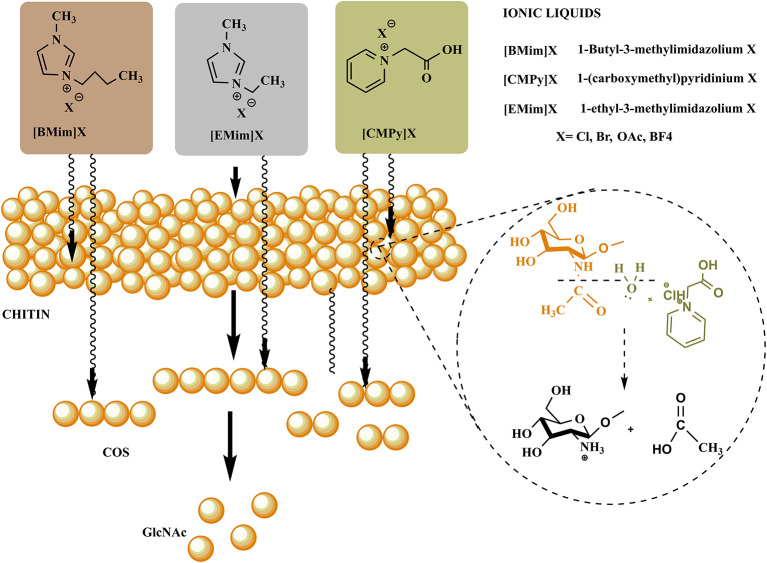
Conventional and emerging green chemicals based production steps of COS and GlcNAc.